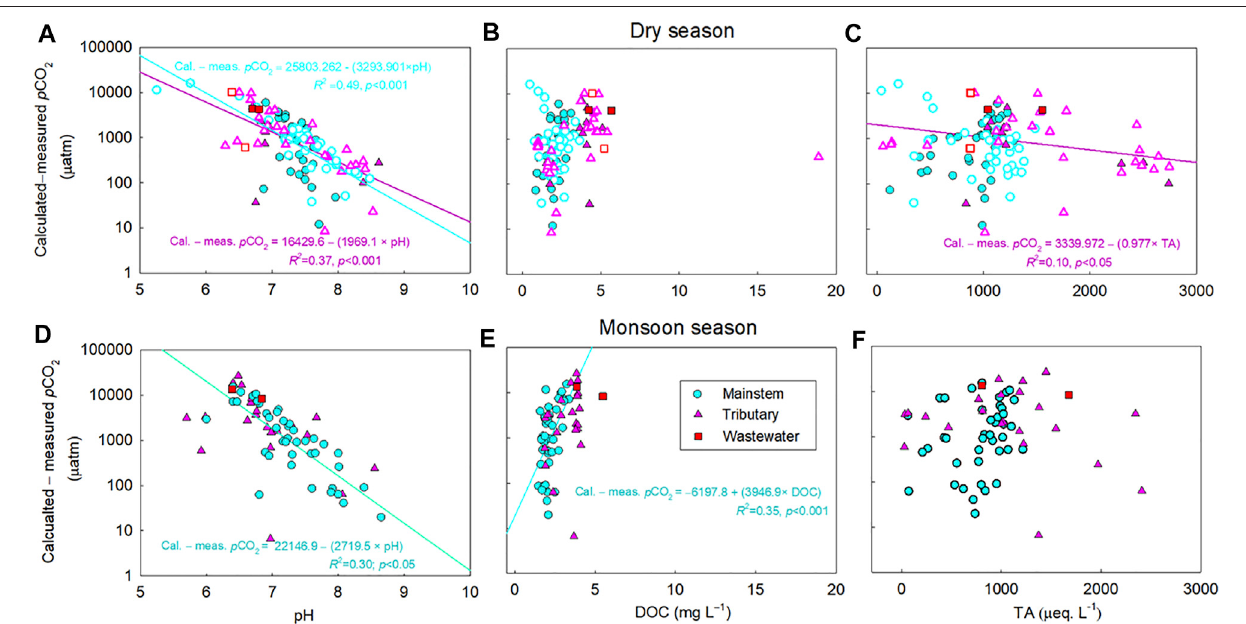
FIGURE6| Relationshipsbetween thecalculated minus measured partialpressureofCO 2 ( p CO 2 ) and pH (A, D) ,dissolved organiccarbon (DOC) (B, E) ,and total alkalinity(TA) (C,F) inthemainstems(M),tributaries(T),andwastewateref fl uents(W)oftheHanRiverduring themonsoon anddryseasons.FortheHanRiver, 212data points are presented from Figure 2 (excluding 6 extreme values exceeding 35,000 and 25,000 µatm during the monsoon and dry periods, respectively), including the mainstem (M) (n: 55 for monsoon season; 83 for dry season), tributaries (T) (n: 25 for monsoon season; 43 for dry season), and wastewater (W) (n: 2 for monsoon season; 4 for dry season) from 2014 to 2020. For the dry season, samples are indicated by fi lled symbols for the months without “ rainfall, ” while void symbols represent the months with “ sporadic rainfall. ” The signi fi cant relationship ( p < 0.05) is indicated by a regression line through the plot. The difference between calculated p CO 2 and measured p CO 2 against pH was plotted in y-axis in